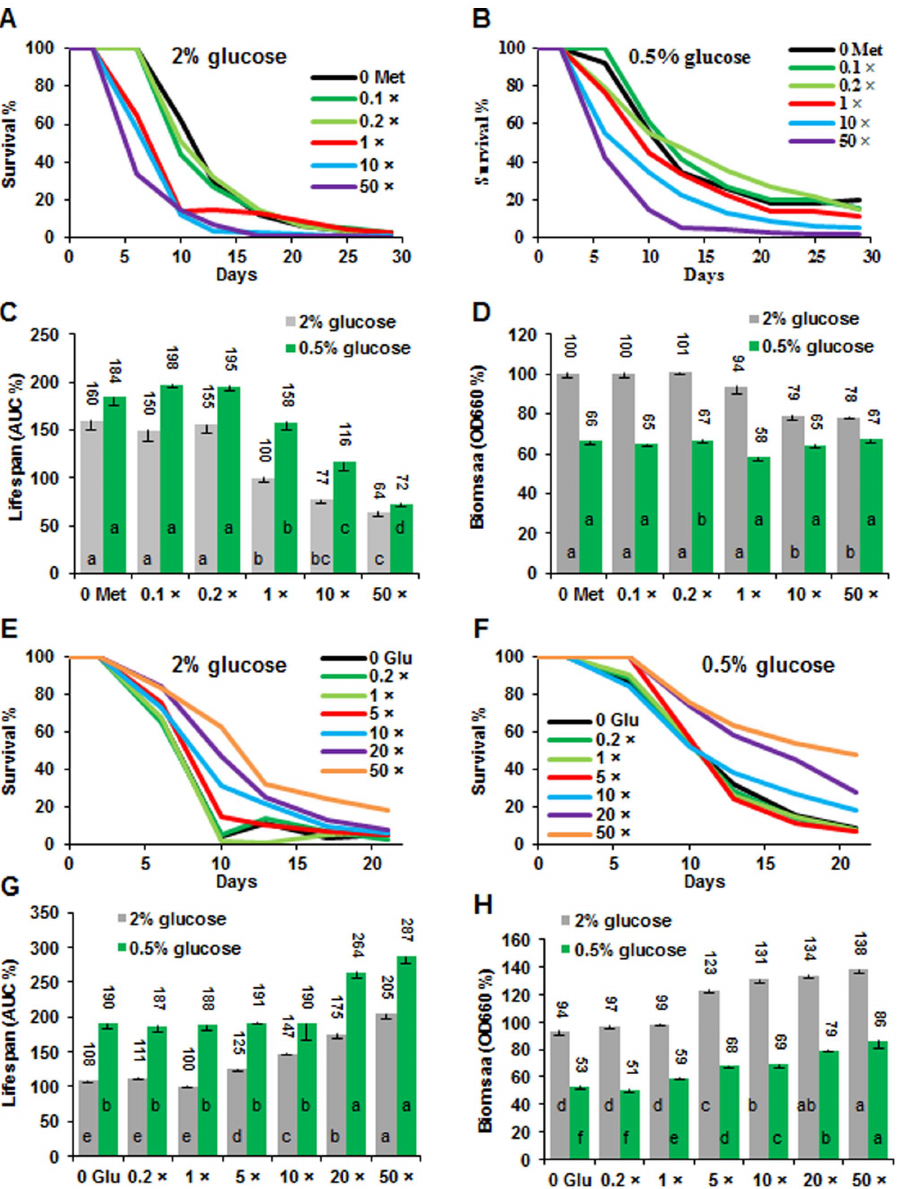
Figure 5. Methionine and glutamic acid cause lifespan and biomass alterations in yeast. Survival curves of wild-type yeast were cultured in normal (2% glucose, A ) and CR (0.5% glucose, B ) media containing different methionine levels (0 to 50 6 , 0 to 4000 mg/L). CLS ( C ) and biomass ( D ) comparisons of yeast were incubated in media with diverse methionine levels. AUC or biomass of the control (1 6 Met with 2% glucose) was defined as 100%. Survival curves of wild-type yeast grown in normal ( E ) and CR ( F ) conditions containing different glutamic acid levels (0 to 50 6 , 0 to 5000 mg/L). CLS ( G ) and biomass ( H ) comparisons of yeast were grown in media with diverse glutamic acid levels. AUC or biomass of the control (1 6 Glu with 2% glucose) was defined as 100%. Data were expressed as mean 6 s.e.m. (n=4) ( C and D ), n=6 ( G and H ); compared using Duncan’s multiple range test at P , 0.05 and different lowercase letters in columns indicate significant difference.